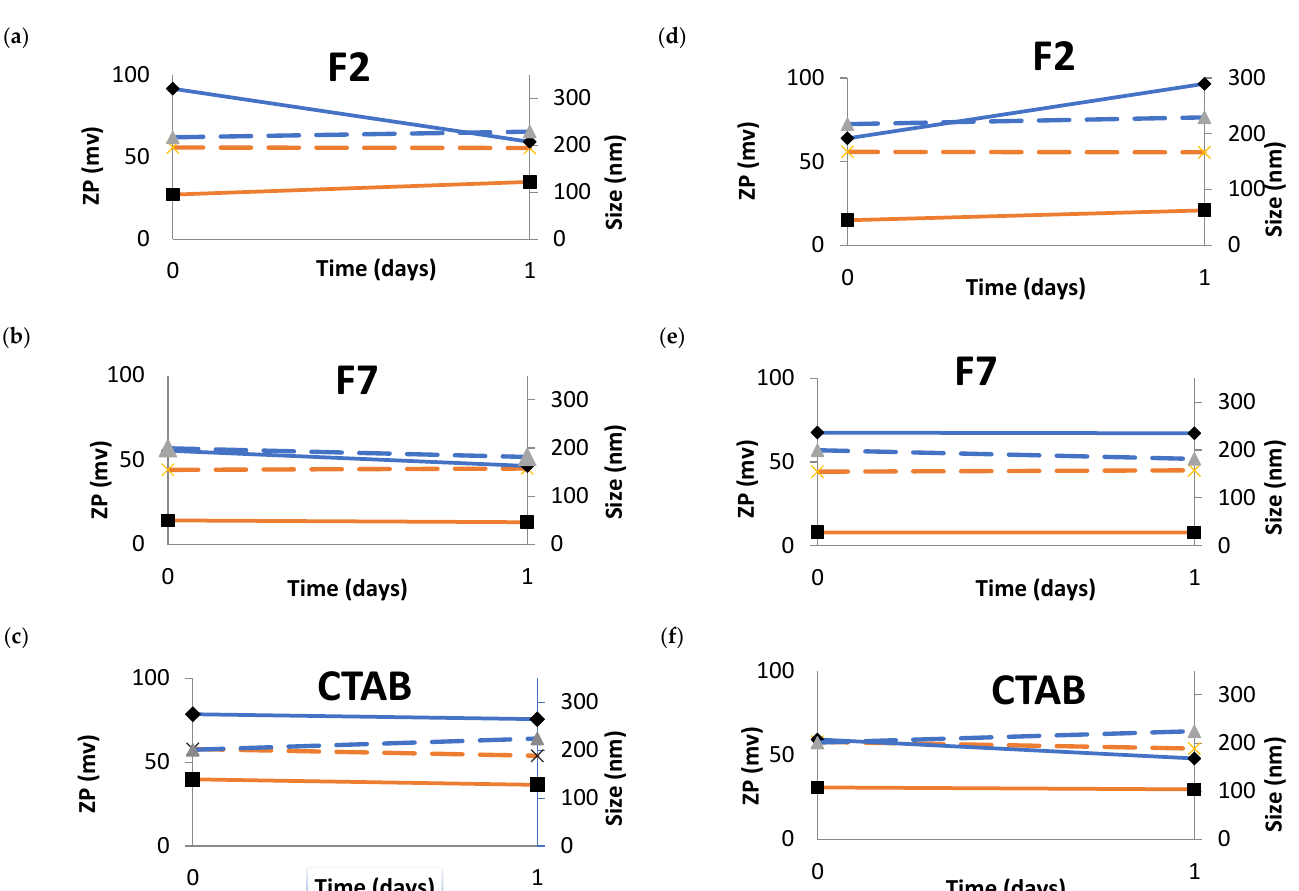
Figure 11. Zeta potential variation recorded on day zero and 24 h after production of NEs, determined in sterile saline solution, for two distinct dilutions at 1:1 (left-hand side panels, ( a – c )) and at 1:3 (right-hand side panels, ( d – f )). Blue line refers to: mean particle size of NEs after dilution in the different solutions (continuous line) and mean particle size of original NEs (dashed line); orange line refers to: ZP of NEs after dilution in the different solutions (continuous line) and ZP of original NEs (dashed line).